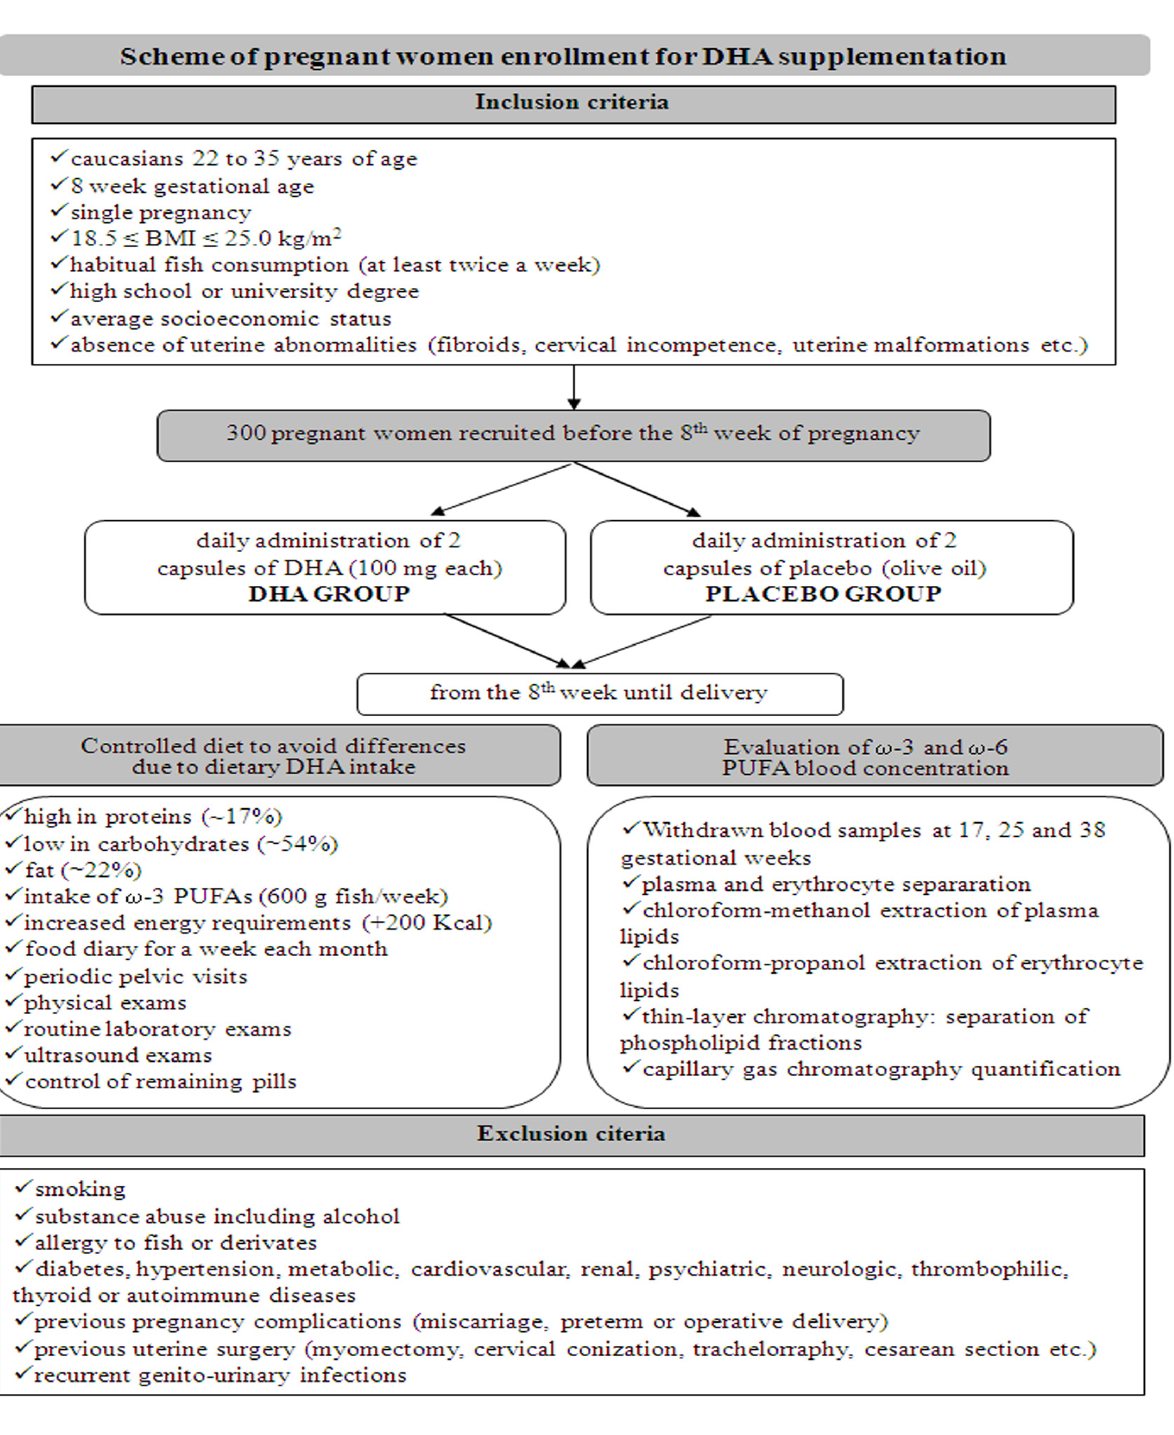
Figure 2. Scheme of pregnant women enrollment: inclusion and exclusion criteria, diet features and laboratory exams for monitoring of DHA